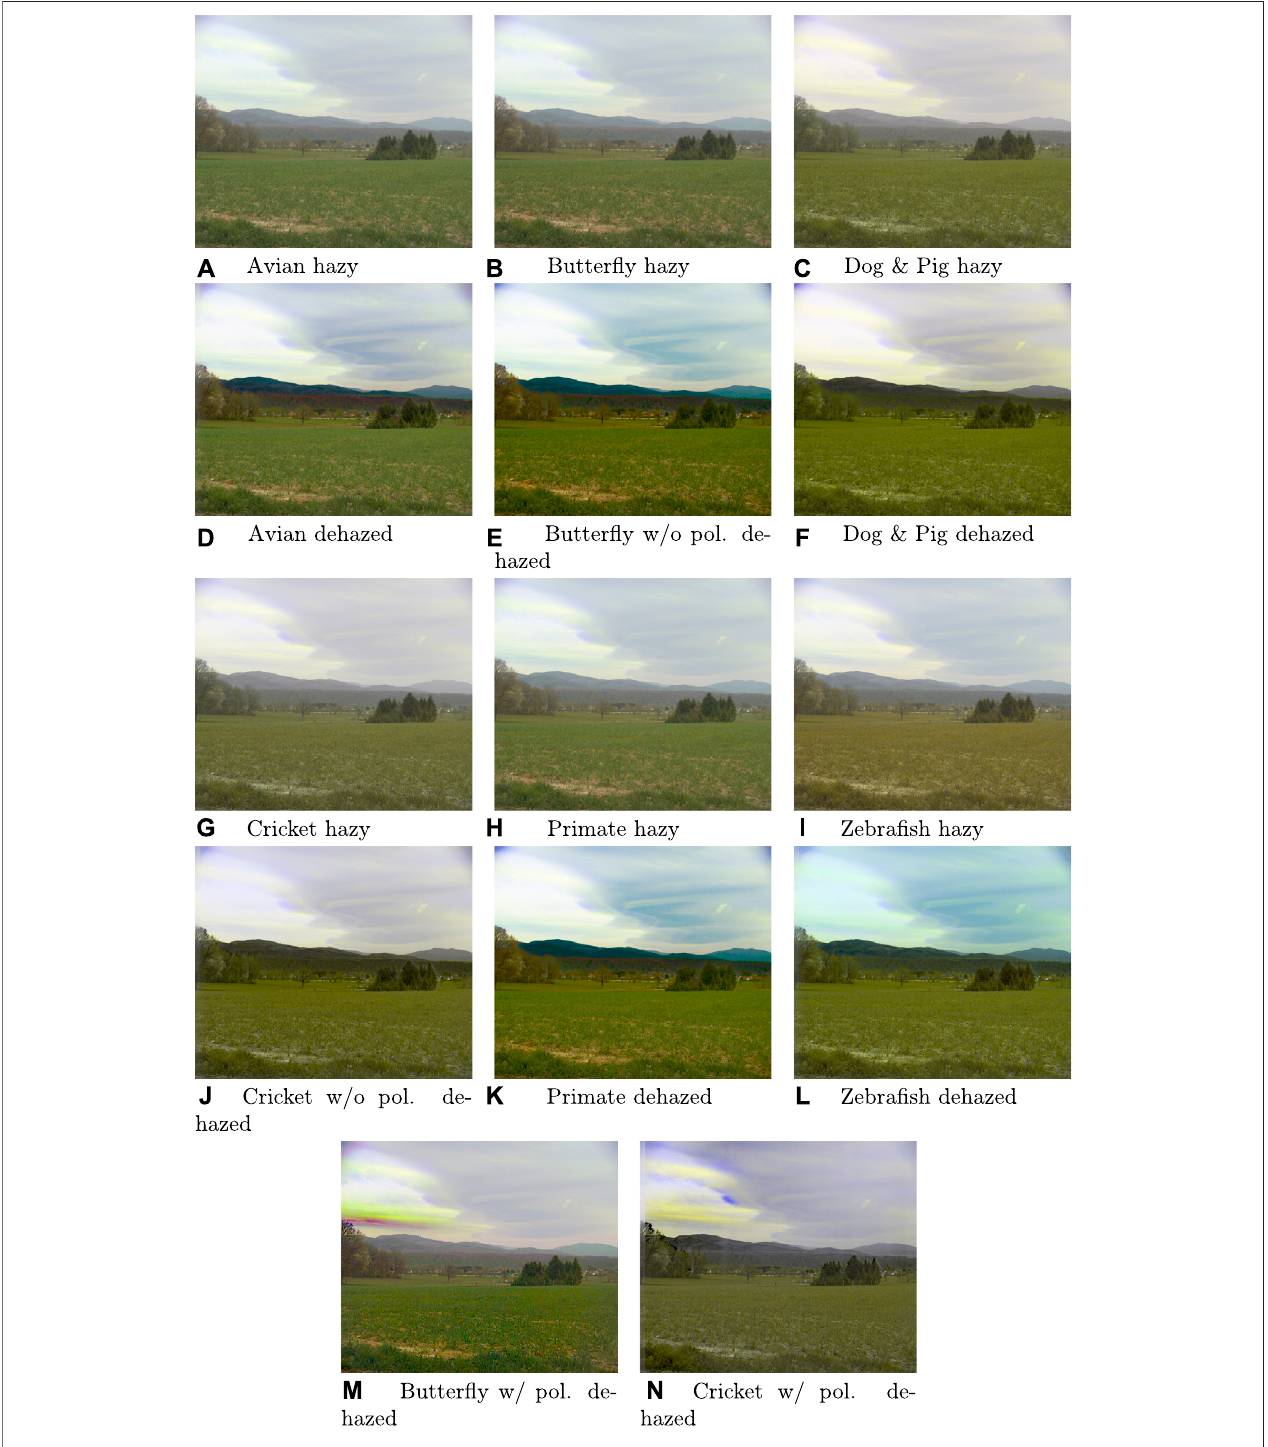
FIGURE 5 | sRGB visualization (scene 1) of images before and after dehazing for each animal.